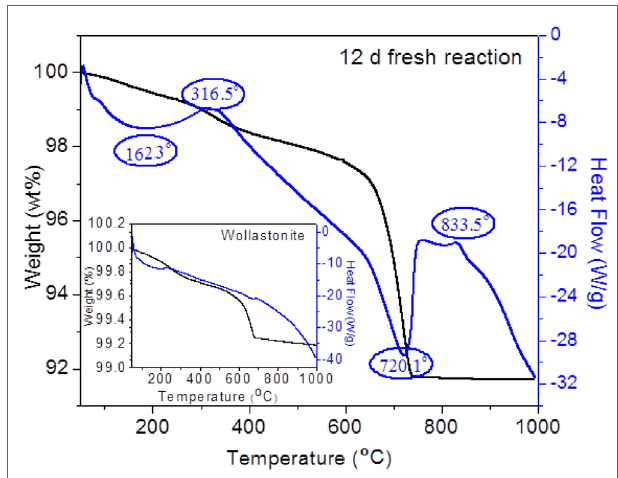
FigUre 3 | Tga/Dsc curves for the 12-day “solution replacement” reaction and the original casiO 3 powder (insert plot) .